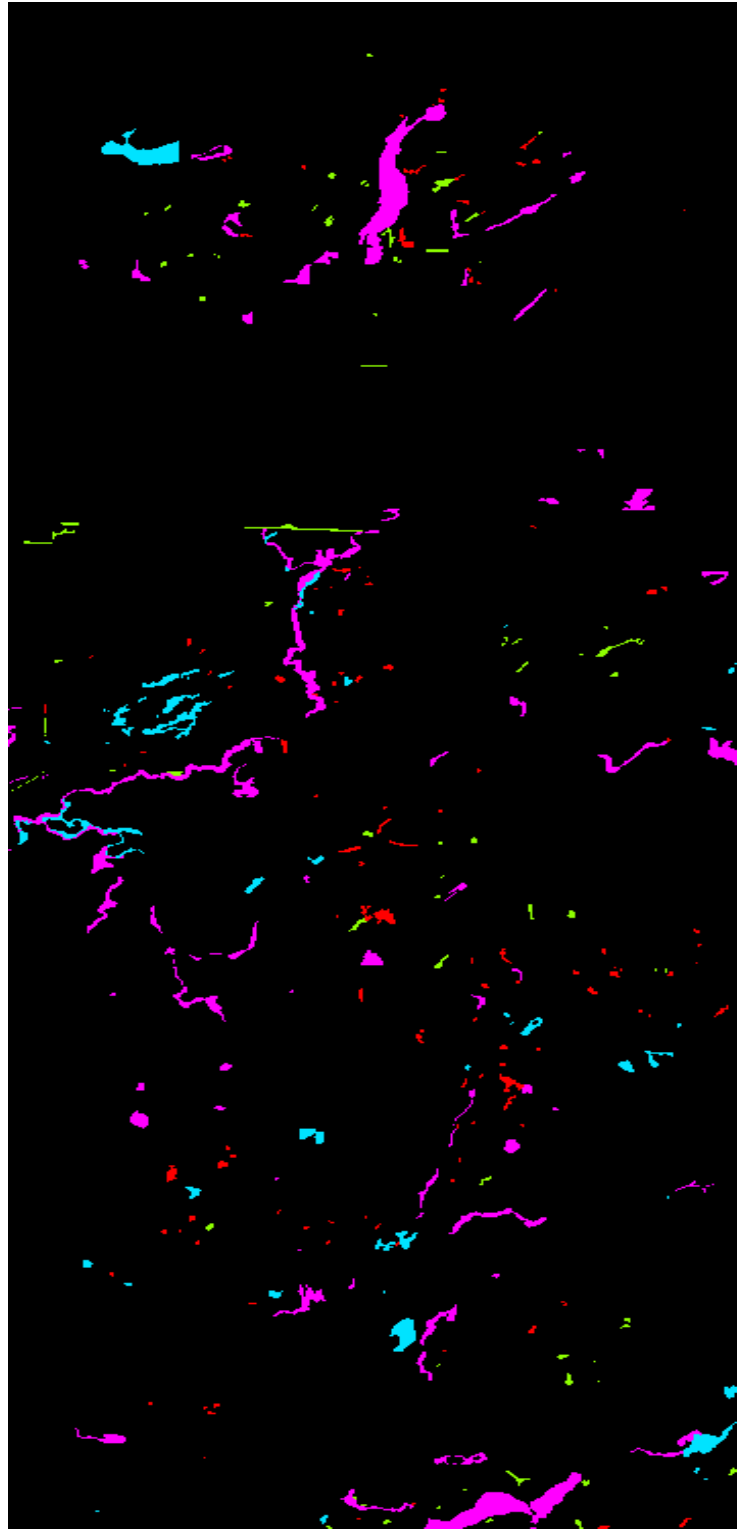
Figure 6. Nicolet vegetation cover image for which GPS training sets image in Figure 6 that was overlaid. The scene ID # is TM930810. Left image is the corrected image; the right image is the uncorrected